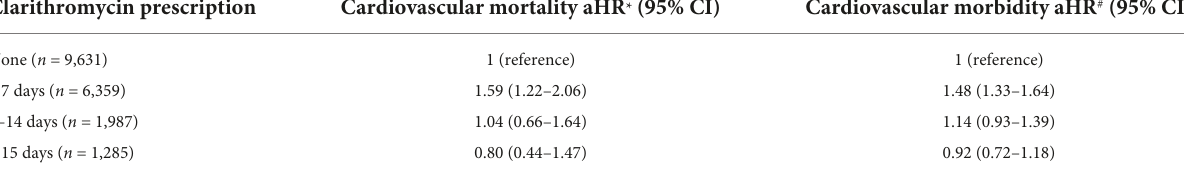
TABLE 5 Association of dosing period of clarithromycin with cardiovascular outcomes. Clarithromycin